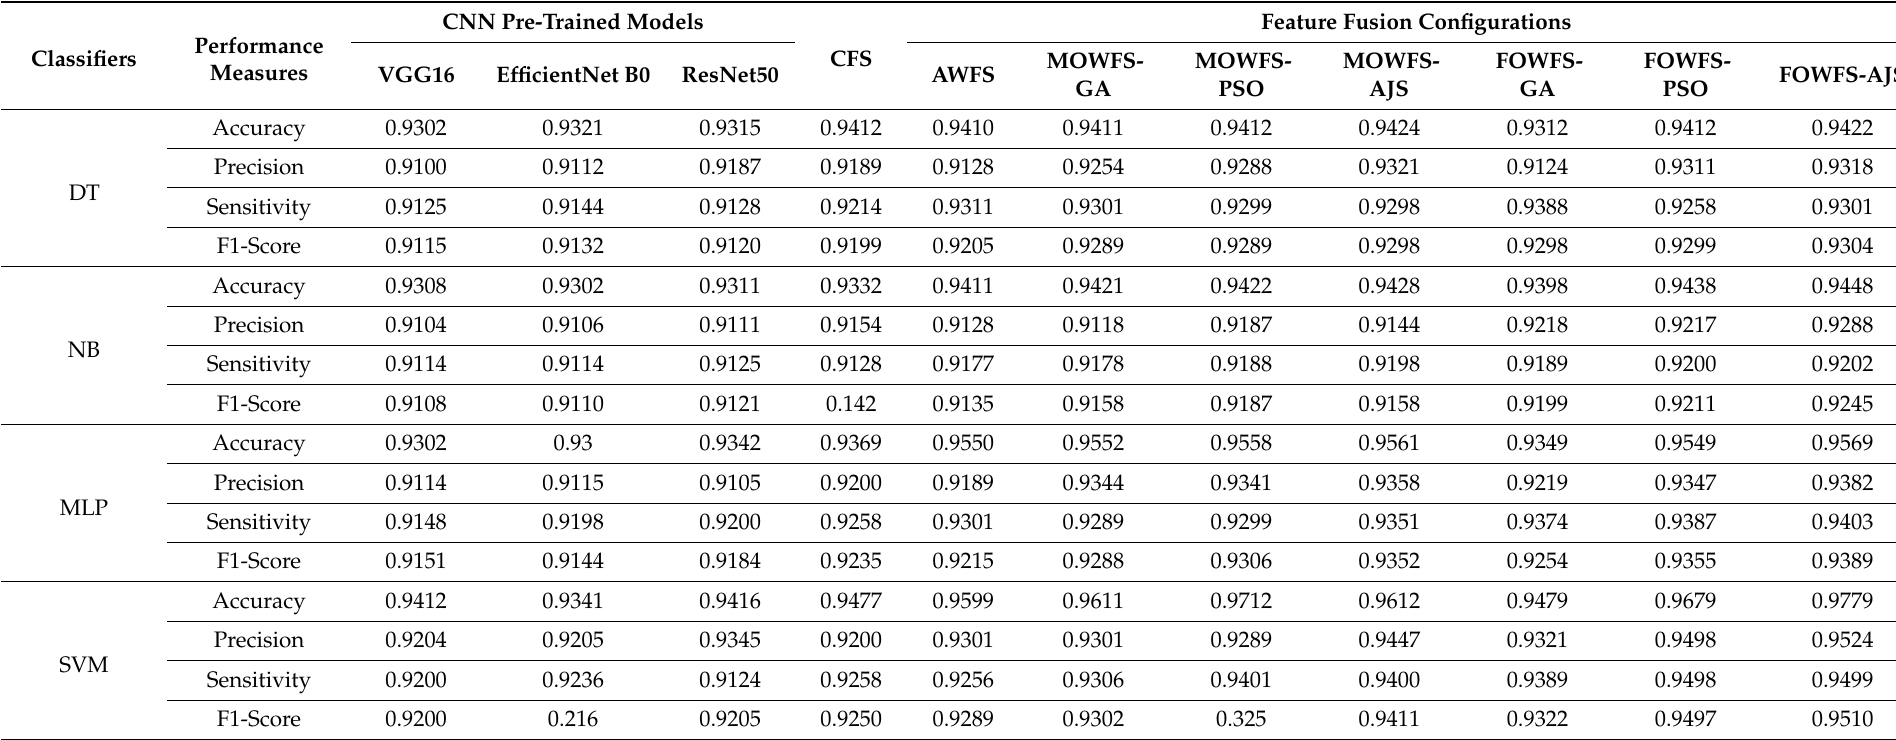
Table 8. Recognition performance with respect to CNNs’ pre-trained models, CFS, and feature fusion configurations for HAM 10000